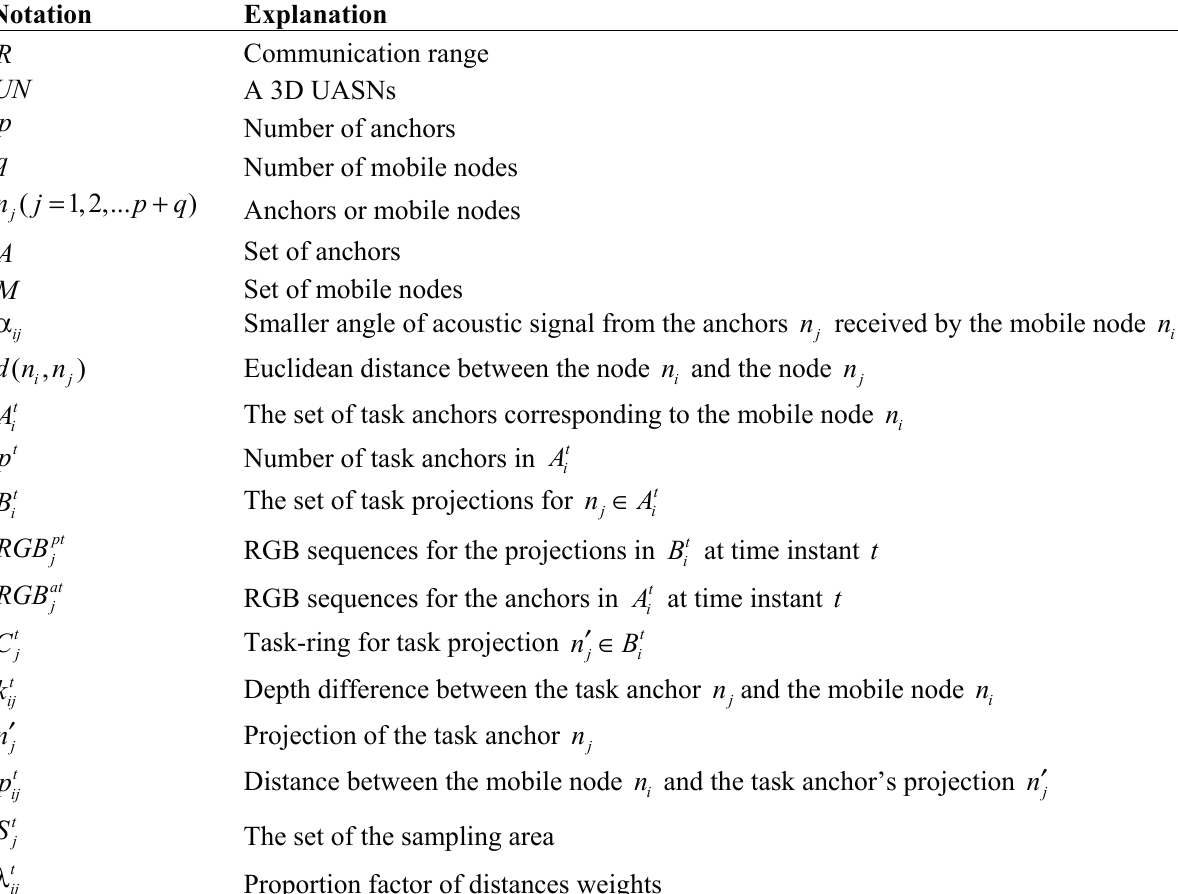
Table 1. List of key